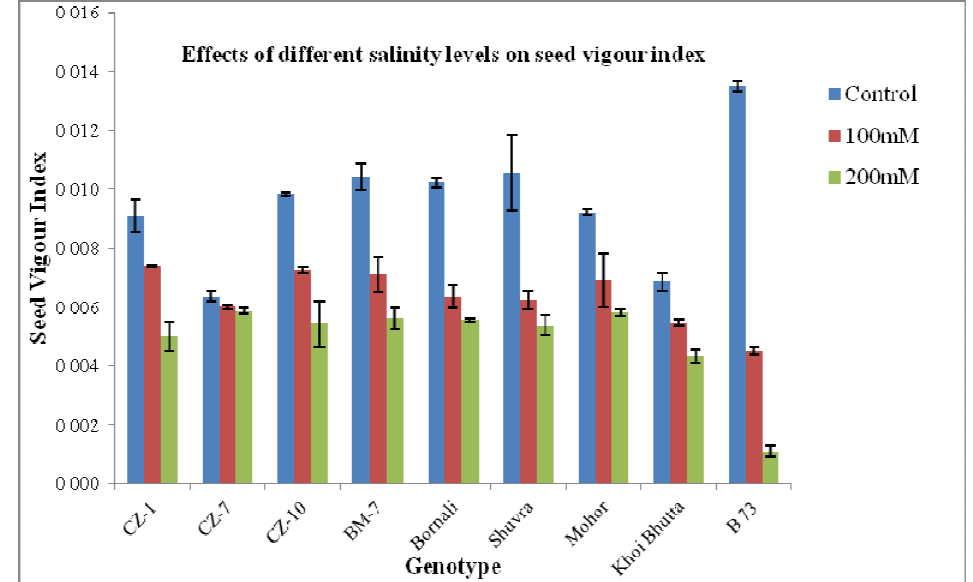
Fig. 6. Effects of different salinity levels on seed vigor